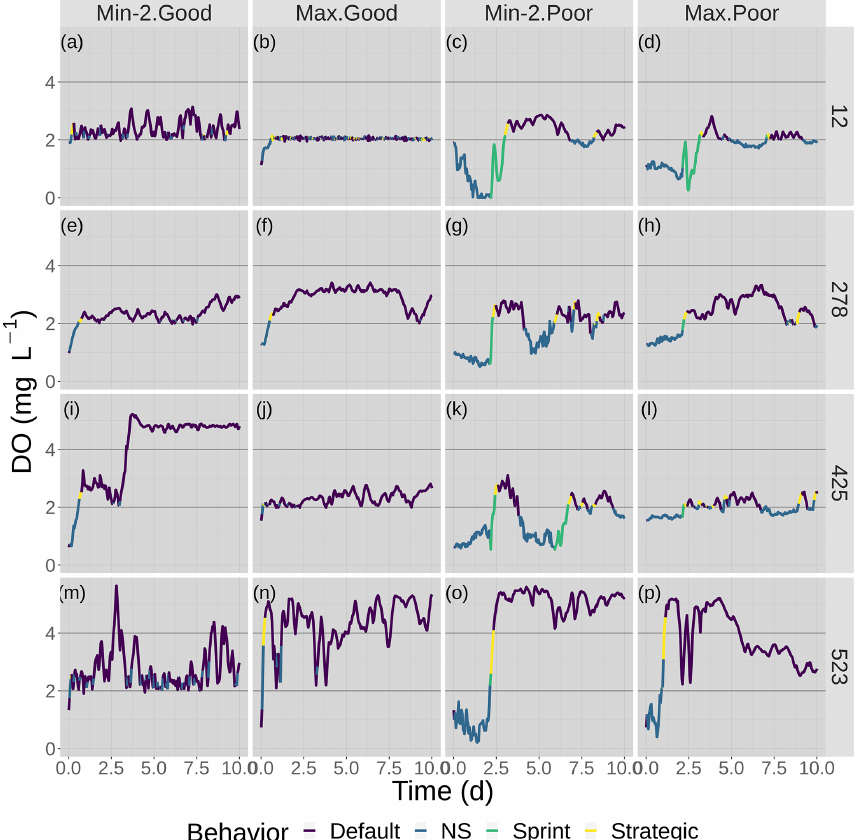
Figure 6. Time series of DO experienced by the four fish shown in Fig. 7 over the 10d of the model for good and poor avoidance and the two snapshot DO maps (Min-2 for moderate sublethal and Max for high sublethal area). The color of the lines denotes the movement algorithm that each individuals was using. Black lines denote the thresholds for hypoxia (2mgL − 1 ) and the upper value (4mgL − 1 ) considered for sublethal